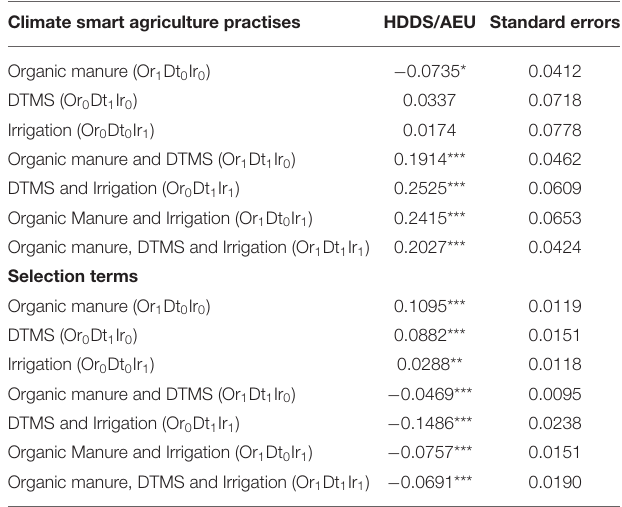
TABLE 3 | Multinomial endogenous treatment affects model estimates of CSA-practises impacts on household dietary diversity per adult equivalent unit. Climate smart agriculture